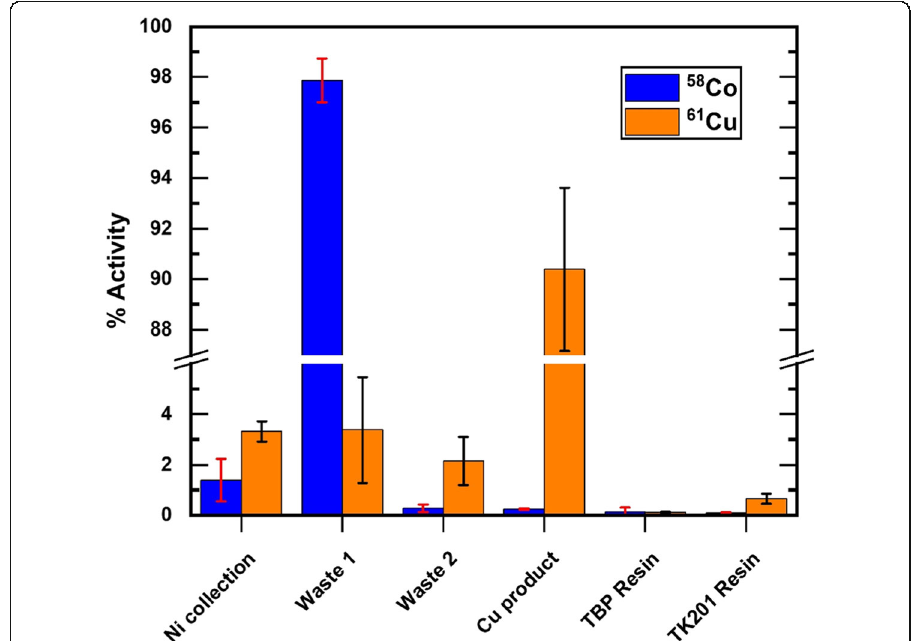
Fig. 2 Bar diagram presenting the normalized activity distribution of 58 Co and 61 Cu. Note that the 58 Co and 61 Cu have been normalised